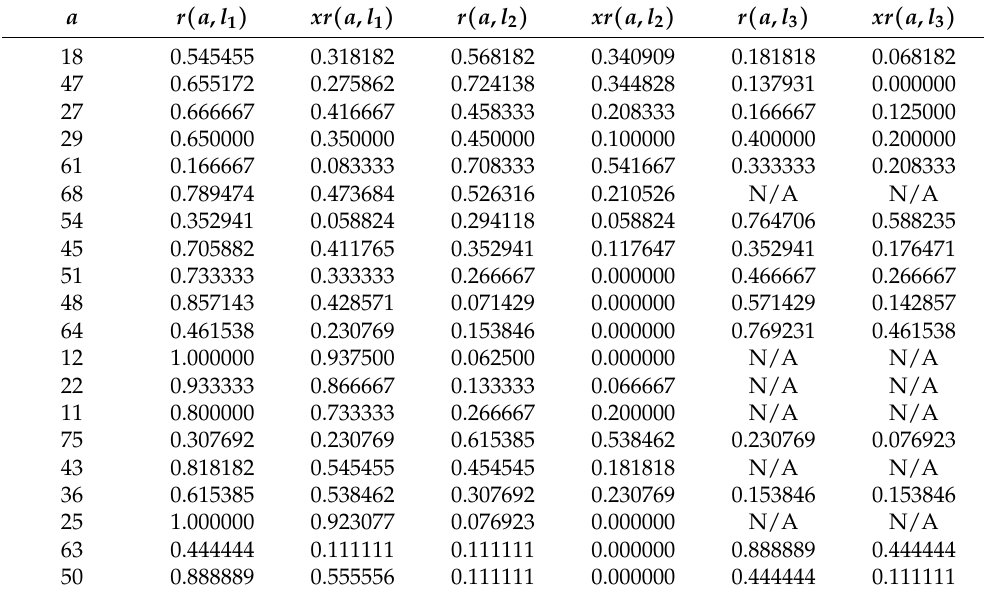
Table 4. Relevance and exclusive relevance of the 20 highest-degree actors on each layer of the Montagna multiplex network.